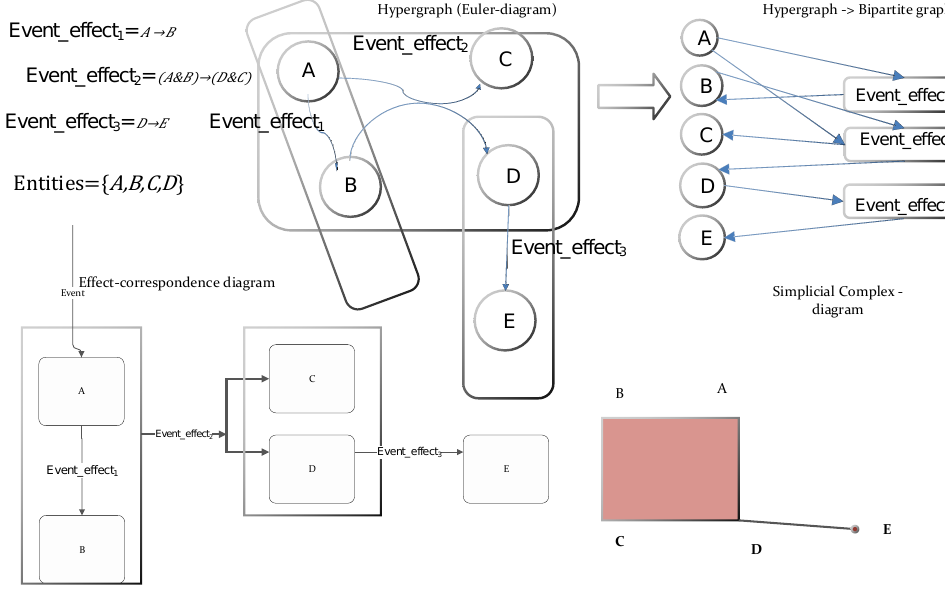
Figure 7. Navigation path: correspondence network of effects of